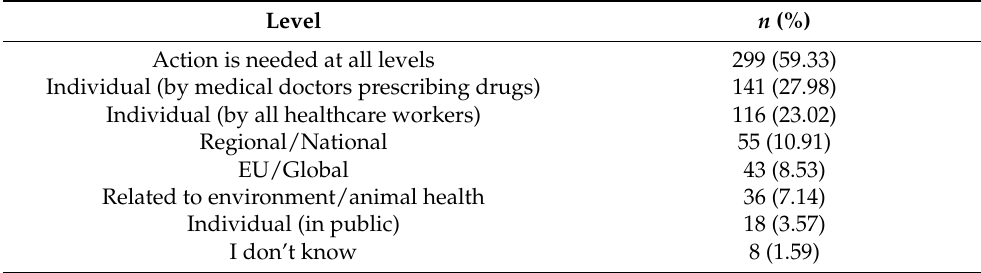
Table 4. At what level is raising the issue of antibiotic resistance the most effective? ( n =